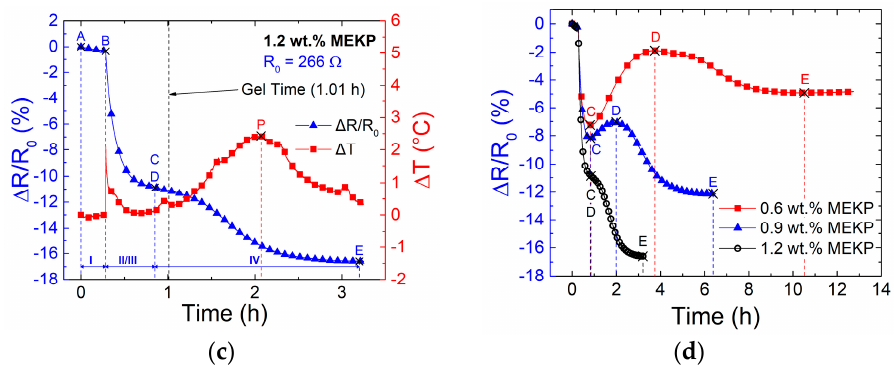
Figure 5. Dynamic evolution of fractional change of electrical resistance and temperature change within the 1.65 mL coupon during VER polymerization for different MEKP concentrations: ( a ) 0.6 wt.%, ( b ) 0.9 wt.%, ( c ) 1.2 wt.%, and ( d ) superposition of the three electrical resistance curves for different MEKP concentrations.